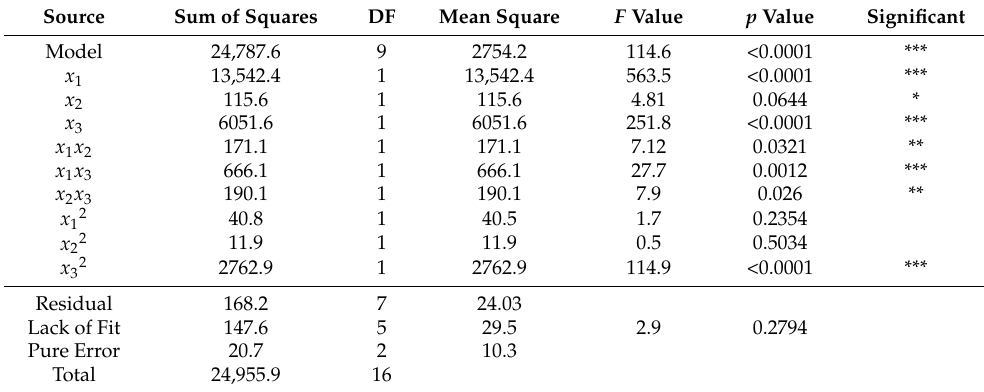
Table 4. Variance analysis of regression equation for soil adhesion.